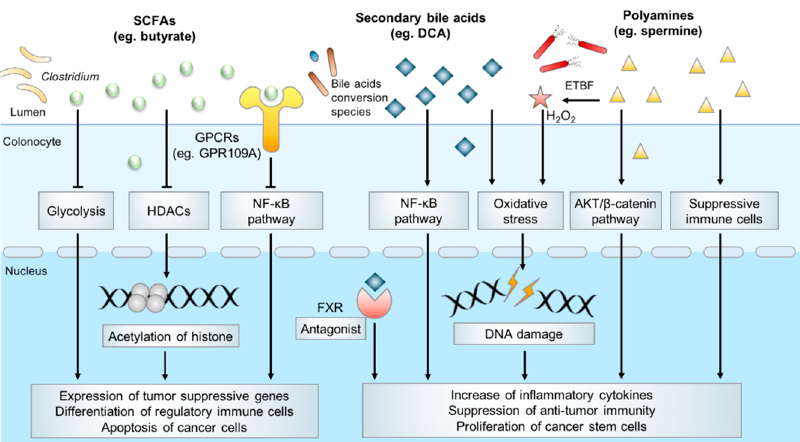
Figure 1. Typical microbial metabolites in CRC pathogenesis.